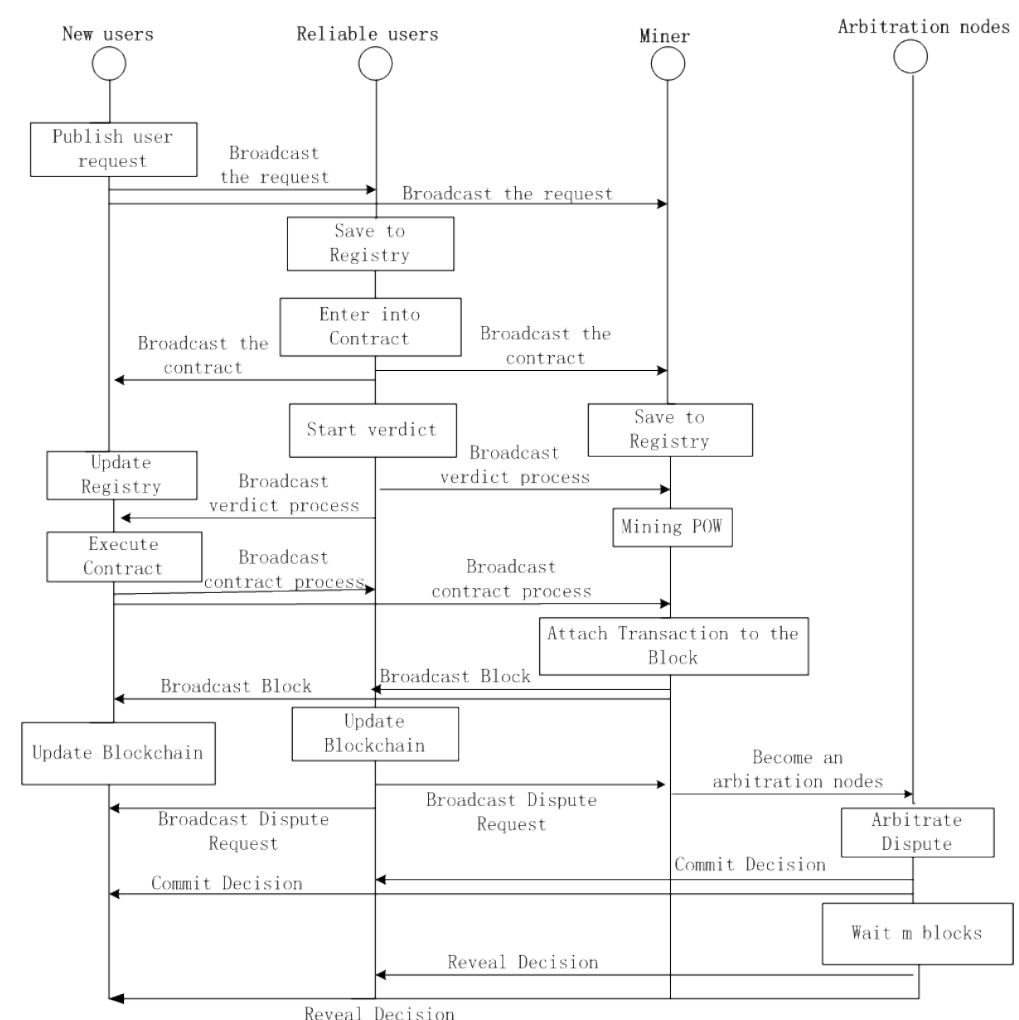
Figure 2. The timing diagram of arbitration